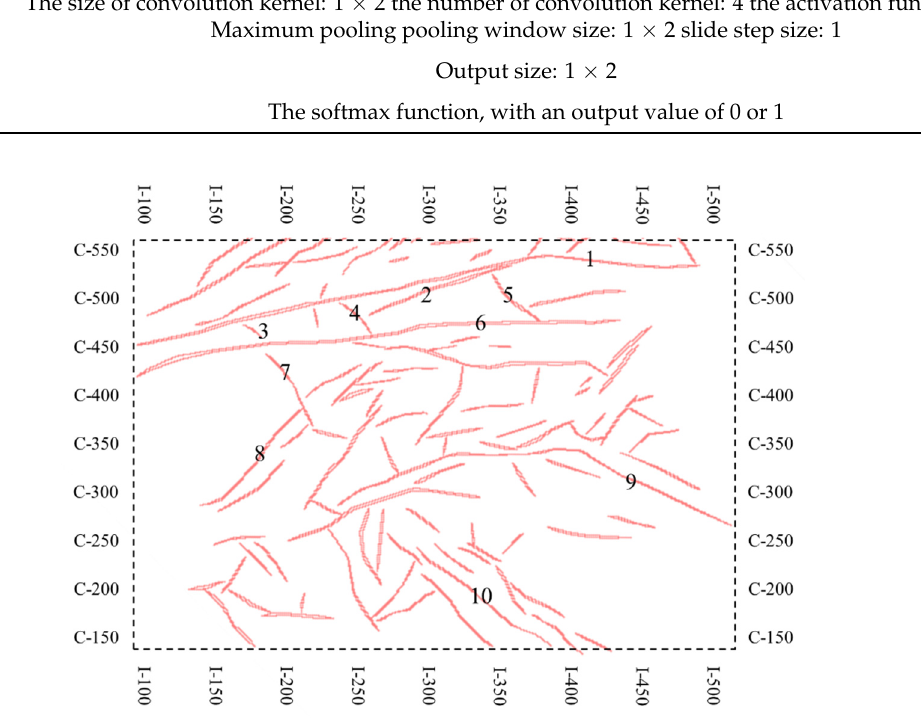
Figure 9. Ten faults in the mining area were selected for comparative experiment .